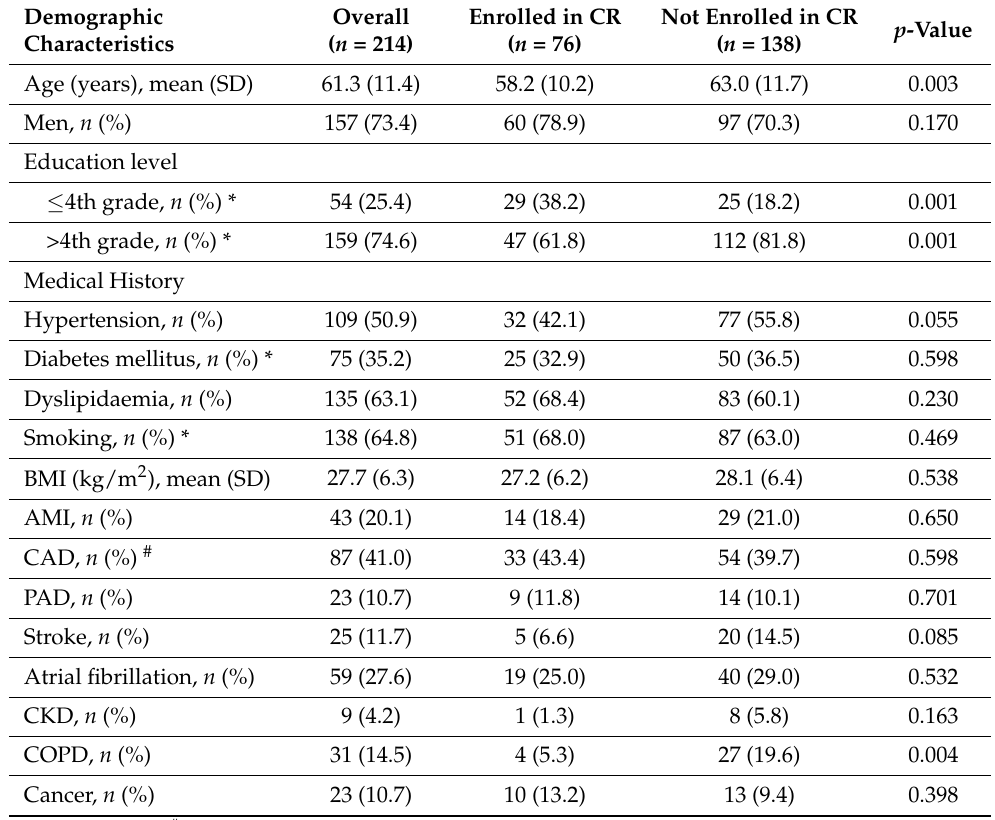
Table 1. Baseline demographic and clinical characteristics of the studied population according to participation in a cardiac rehabilitation